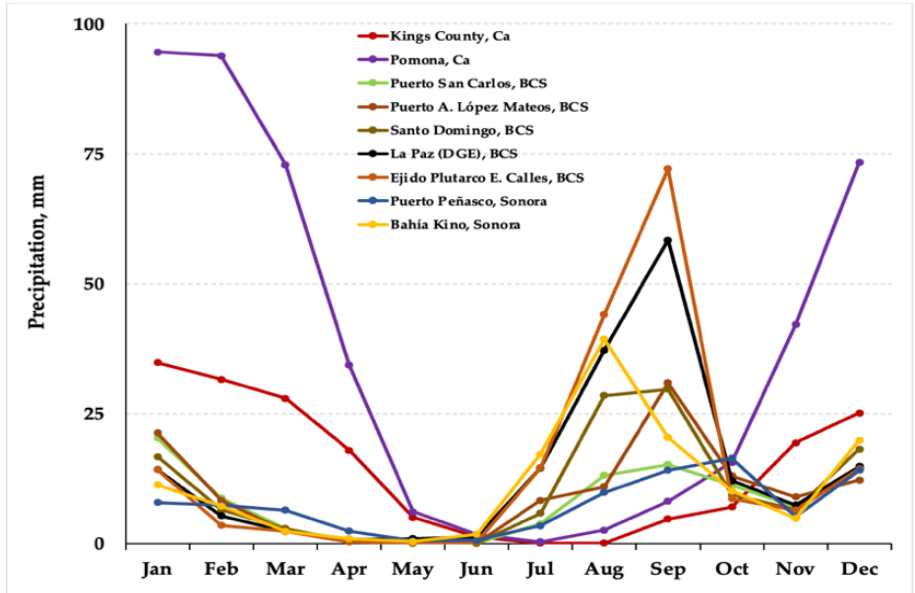
Figure 2. ( a ) Historical precipitation data from six stations in the western region of Mexico (Jalisco, Michoacán, and Guanajuato); and ( b ) from nine stations in the Valley of Mexico and the central- eastern region of Mexico (Tlaxcala, Puebla, Hidalgo, Mexico City and Mexico State), where Suaeda edulis is reported.